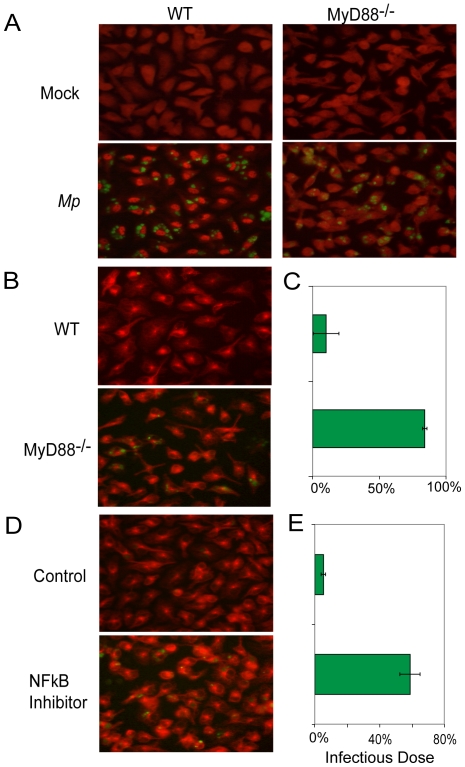
MyD88-NFκB signaling is essential for macrophages to eliminate Mp.(A), (B) and (C), WT and MyD88−/− BMM were infected with EYFP-Mp or mock infected. (A) One hour after infection with EYFP-Mp (green), BMM were stained with anti-NFκB (p65) (red) to determine the subcellular location of this transcription factor. (B) BMM were stained with anti-α-tubulin (red) to highlight cell morphology. The survival of EYFP-Mp (green) was estimated by microscopy, and (C) the survival of EYFP-Mp was analyzed quantitatively by real-time PCR. (D) and (E), WT BMM were pretreated with the inhibitor of NFκB activation or with the diluent control (DMSO) for 1 h prior Mp infection. Eight hours after infection, BMM were stained with anti-α–tubulin (red) to show cell morphology and surviving EYFP-Mp (green) (D). The survival of EYFP-Mp in the cultures shown in (D) was determined by real-time PCR (E). Data shown are representative of two replicate experiments and are means ± SEM (n = 3).